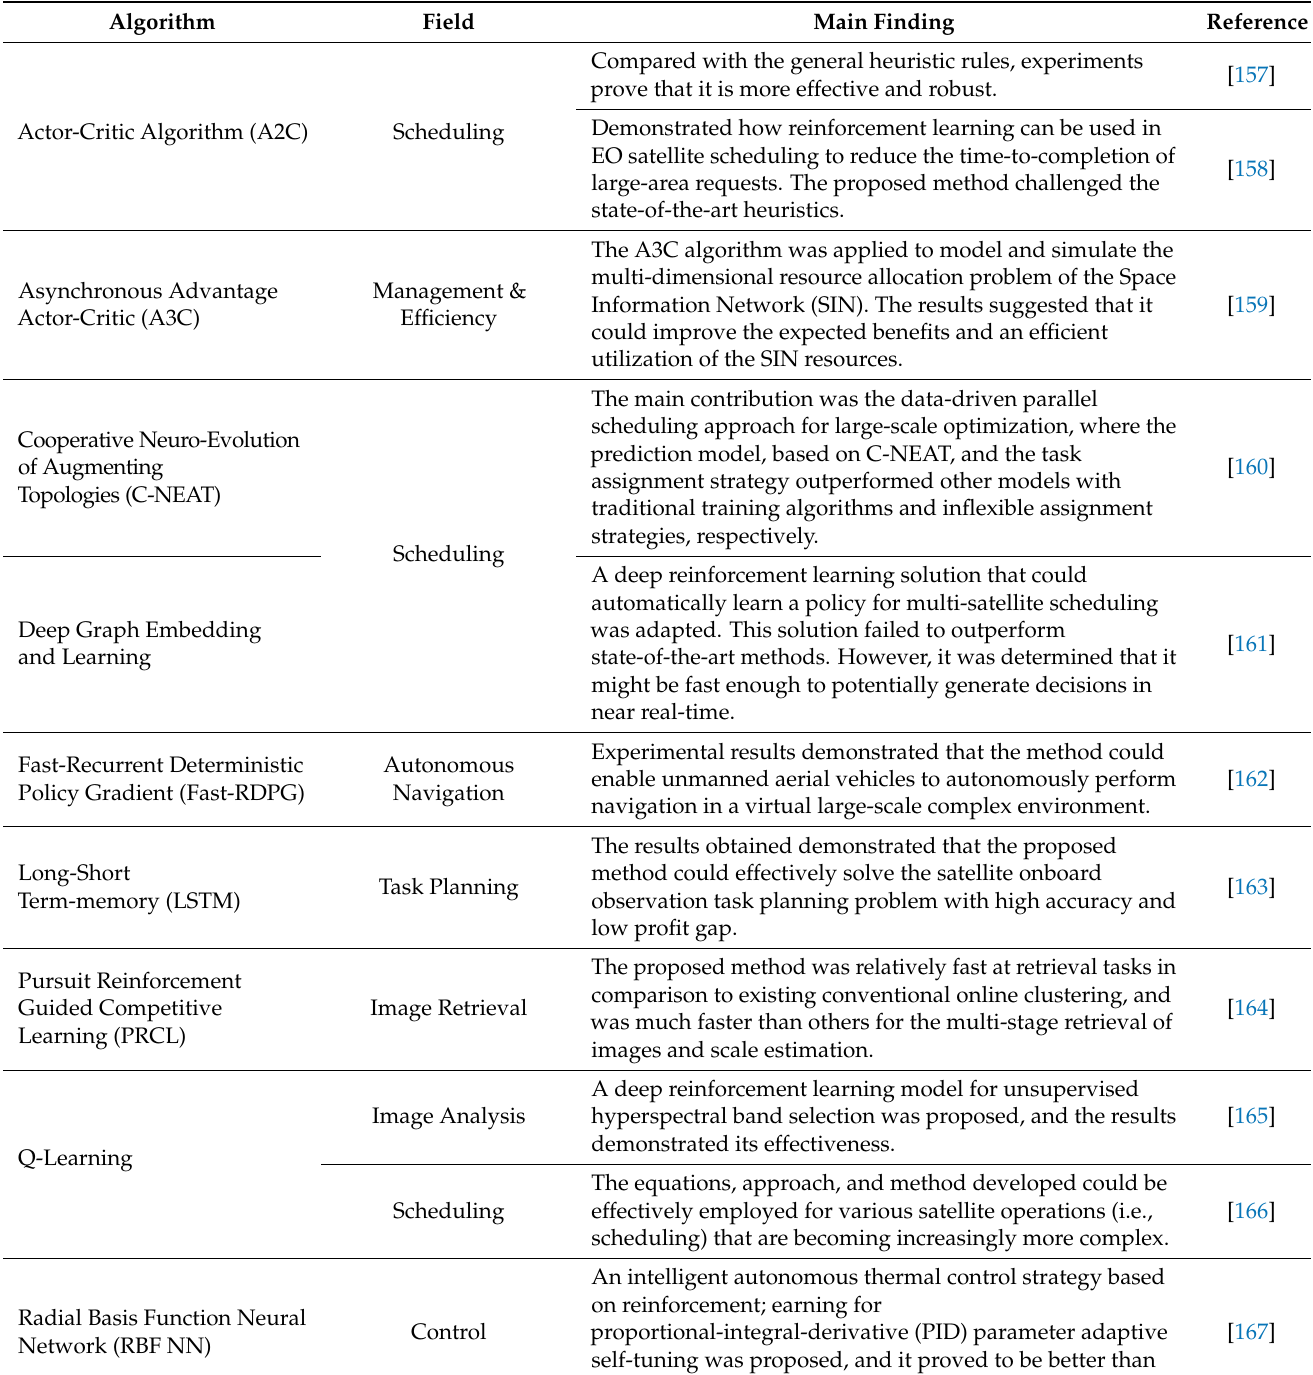
Table 6. Examples of application of reinforcement learning techniques using EO